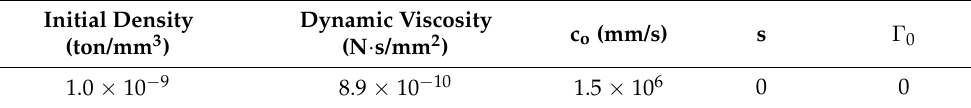
Table 1. Parameters of flow materials.